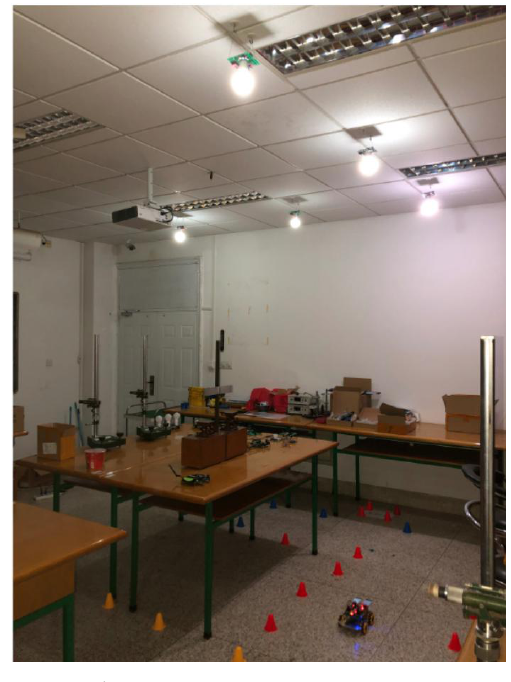
Figure 6 . Experimental scene diagram